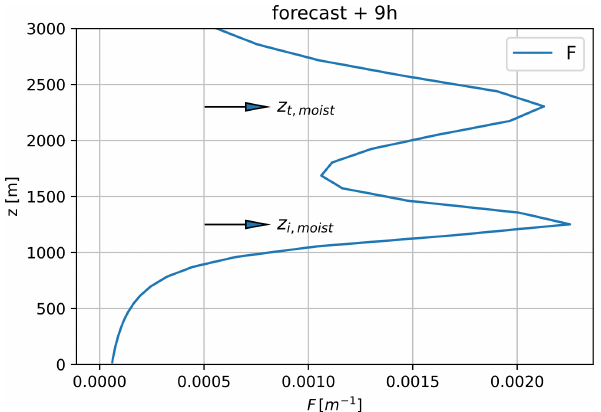
Figure 4. Profile of F (Eq. 19) at the ninth simulation hour of the ARM case (Sect. 3.1) with